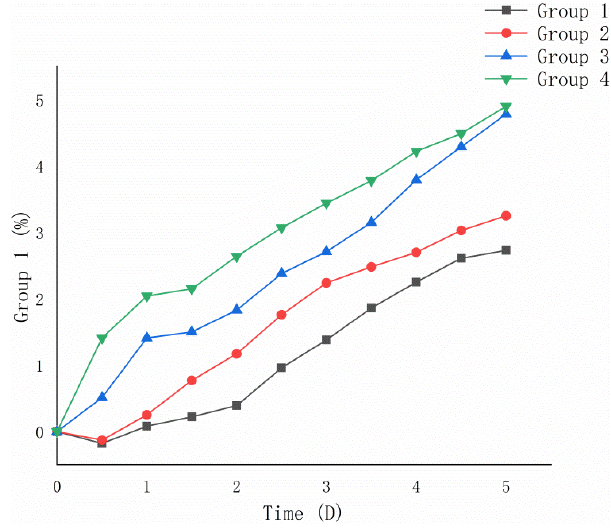
Figure 6. Variation trend of oxidation weight gain rate of ore samples.